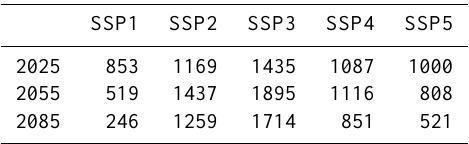
Table 10. Total global withdrawal-based potential industrial water